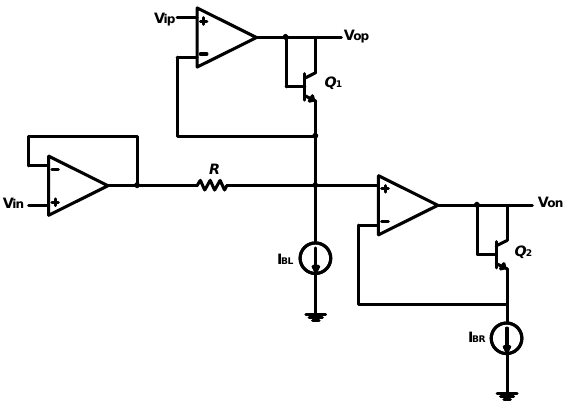
Figure 12. Schematic diagram of the logarithmic